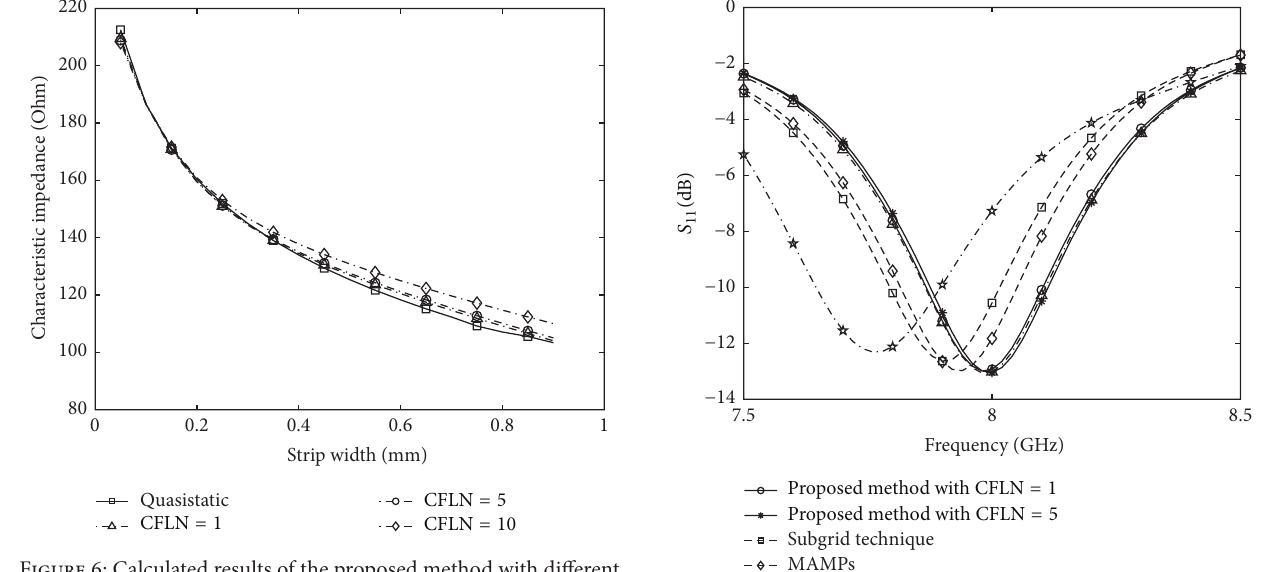
Figure 6: Calculated results of the proposed method with different CFLNs.